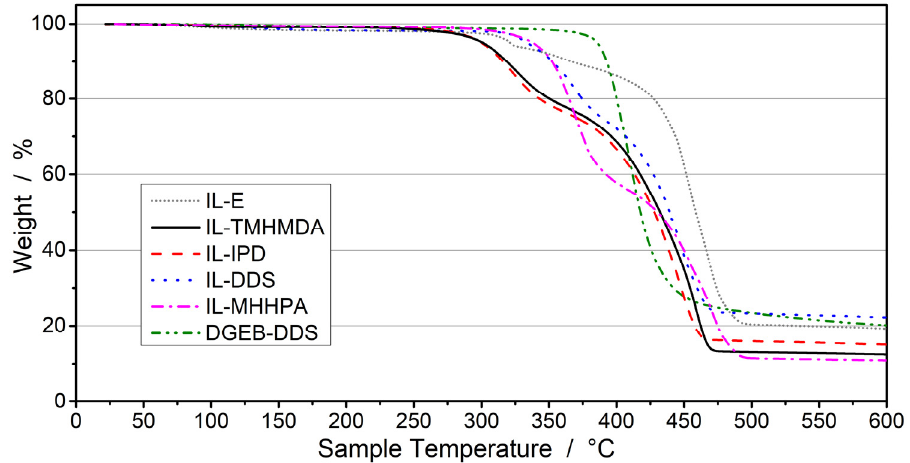
Figure 4. TGA curves obtained for IL ‐ E and fully cured epoxy/hardener compositions.